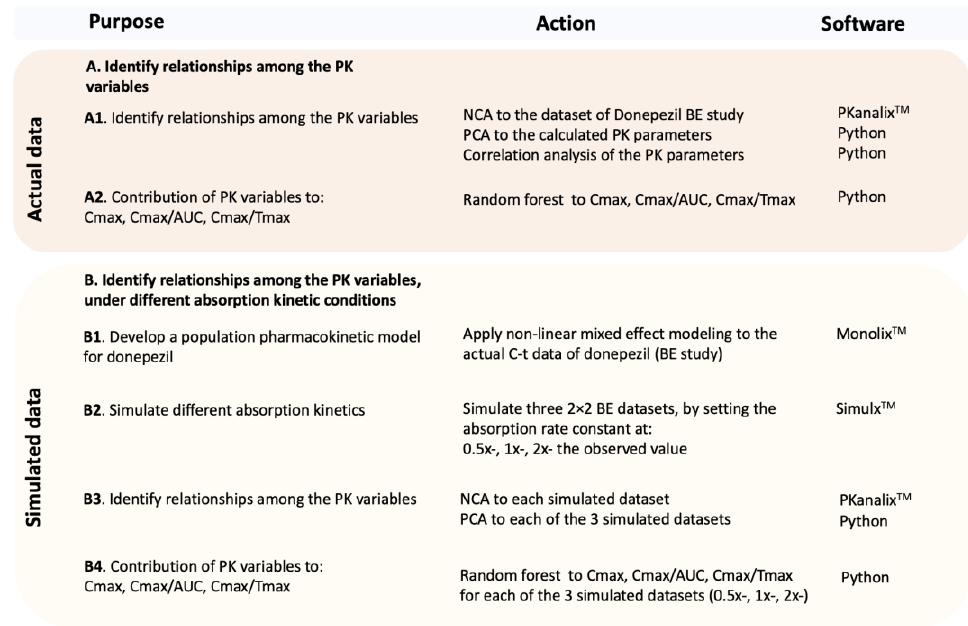
Figure 1. Strategy of the analysis. The basic purposes, actions, and software utilized for each phase of the analysis. Actual (steps: A1 and A2) and simulated (steps: B1 – B4) bioequivalence data are used. of the analysis. Actual (steps: A1 and A2) and simulated (steps: B1–B4) bioequivalence data are